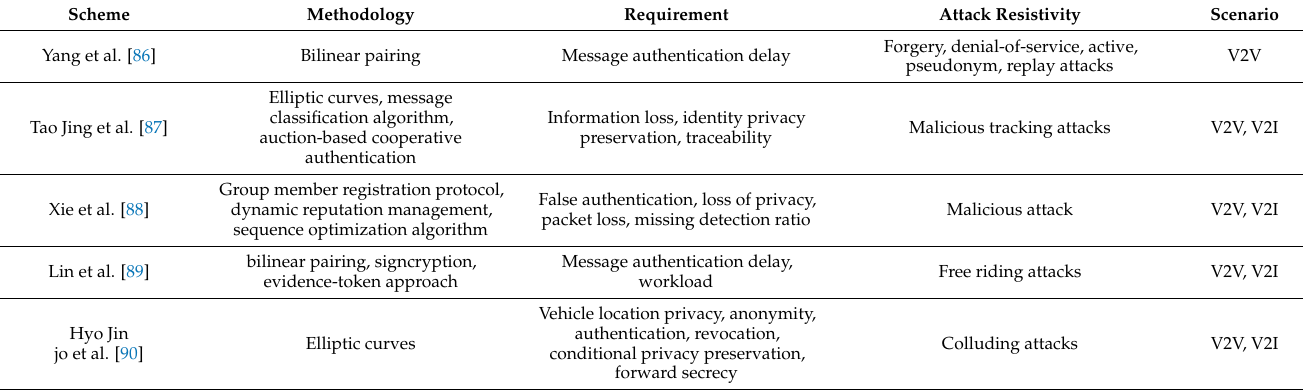
Table 6. Classification of cooperative-authentication-based certificate-less aggregate signature